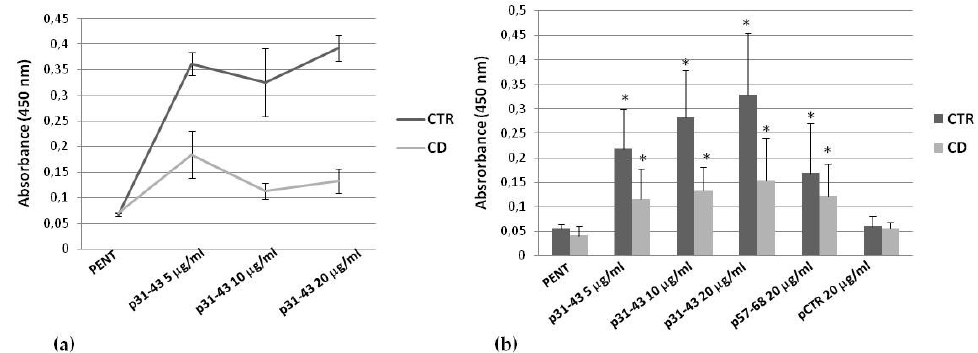
Figure 5. E ff ect of p31–43 on in situ TG2 activity. ( a ) Comparison of TG2 activity induced by 5, 10, and 20 µ g / mL of p31–43 in one representative control culture and one representative CD culture. Basal activity of TG2 was obtained in the presence of pentylamine-biotin (PENT) only. Means and standard deviations of biological duplicates are reported. ( b ) Mean values (and standard deviations) relative to in situ TG2 activity measured in three control cultures and three CD cultures treated with 5, 10, and 20 µ g / mL of p31–43 and with 20 µ g / mL of control peptides. Asterisks (*) indicate that p is < 0.05 vs. respective pentylamine-biotin-treated cells.